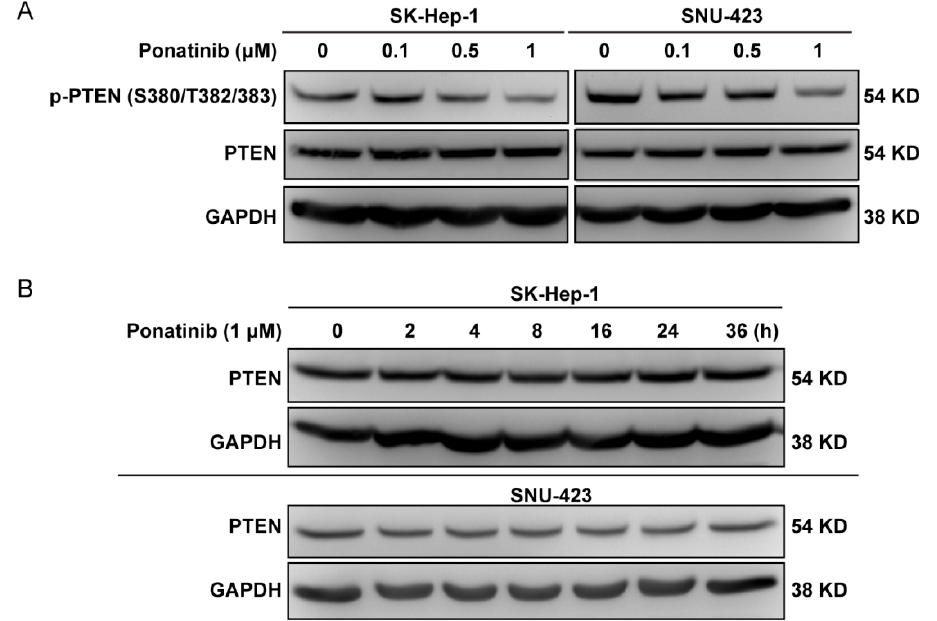
Figure 6. Effect of ponatinib on PTEN. ( A ) Effect of ponatinib on the phosphorylation of PTEN on Ser380/Thr382/383. For the Western blot analysis, SK-Hep-1 and SNU-423 cells were treated with ponatinib at indicated concentrations for 36 h. ( B ) Time course of ponatinib (1 µ M) effect on PTEN in SK-Hep-1 and SNU-423 cells.